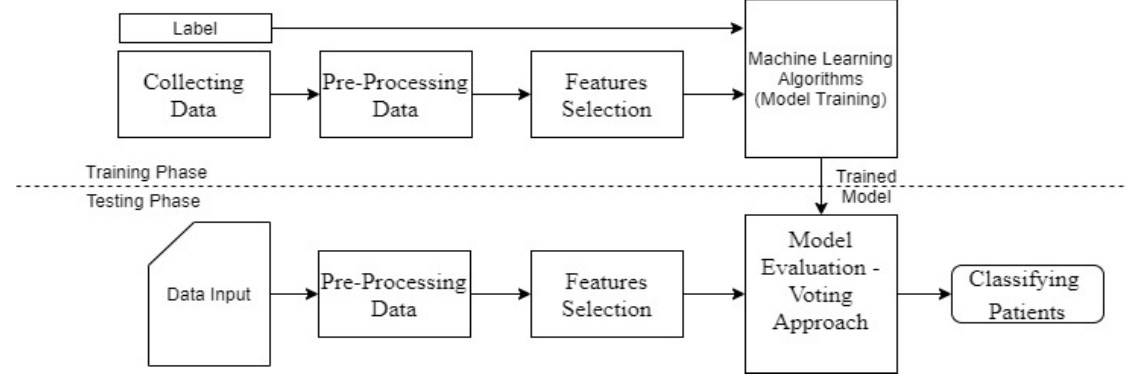
Figure 3. Functionality of supervised classification.